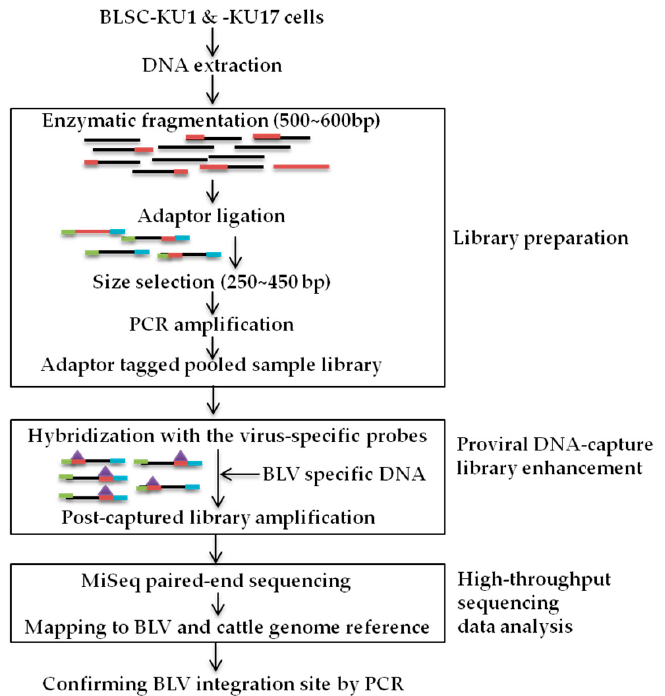
Figure 1. Schematic of BLV proviral DNA-capture-sequencing (proviral DNA-capture-seq) to detect the integration sites of BLV provirus in BLSC-KU1 and BLSC-KU17 cell lines, such as library prep- aration, proviral DNA capture library enhancement, and high-throughput sequencing data analy-